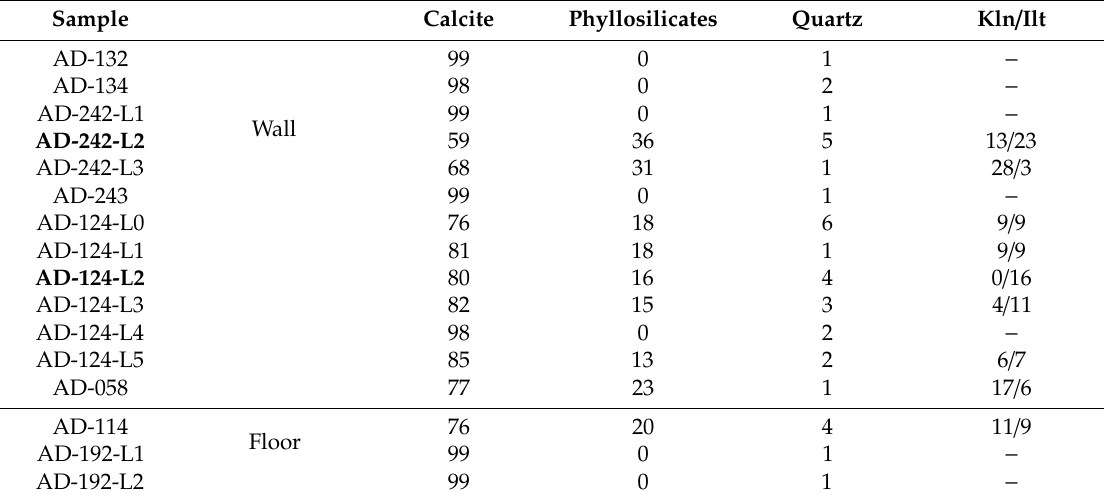
Table 2. X-ray di ff raction (XRD) mineralogical composition of the coarse fraction of mortar